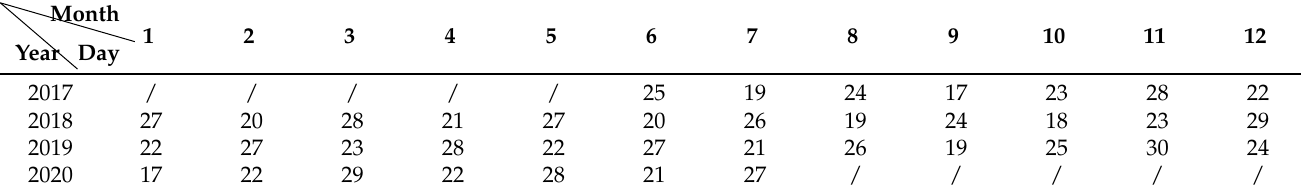
Table 2. The date of Sentinel-1A 38 SAR images acquired from 2017 to